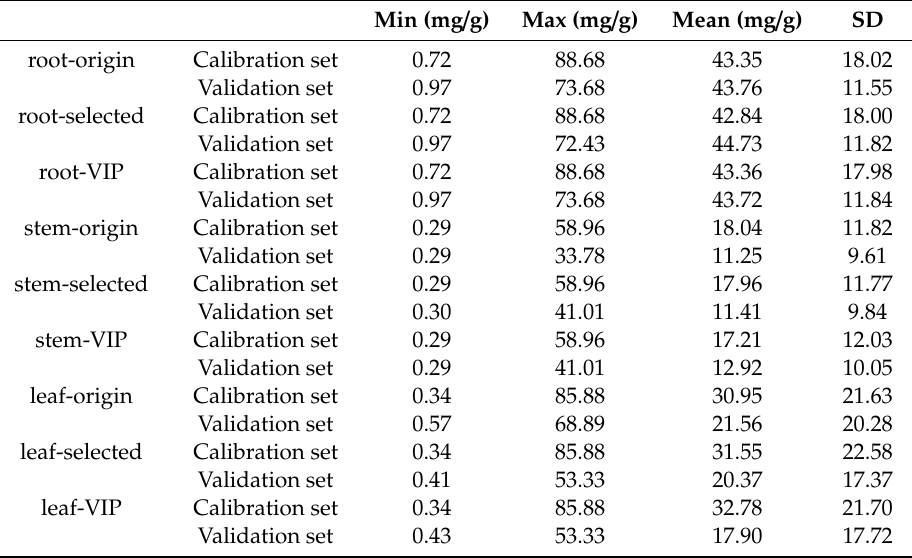
Table 1. The summary of secoiridoids in the calibration and validation